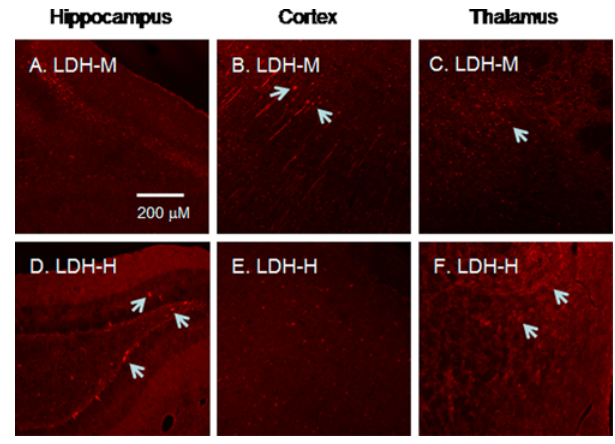
Figure 4. Immunohistochemical images of rat brain cross- sections showing area-specific expression of LDH-M (A–C) and LDH-H (D–F). In hippocampus (A and D), signals for LDH-H predominate (D, arrows) whereas a signal for LDH-M is not evident (A). On the other hand, in cortex (B and E), signals for LDH-M predominate (B, arrows), but a signal for LDH-H is not evident (E). In thalamus (C and F), signals for LDH-H predominate (F, arrows), but a signal for LDH-M is also apparent (C, arrow). Scale bar=200 m m.